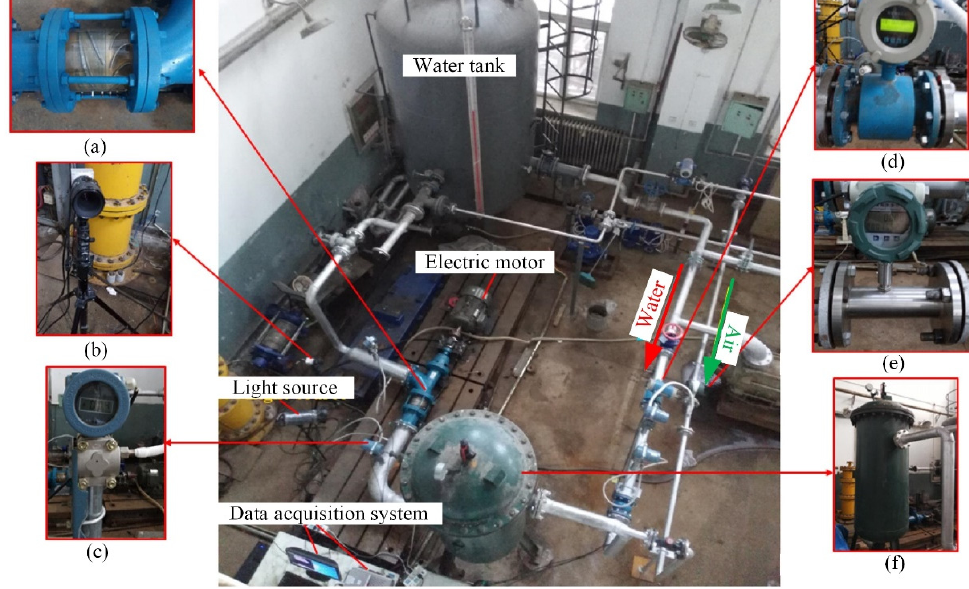
Figure 3. Test bench for the multiphase pump: ( a ) Multiphase rotodynamic pump; ( b ) High-speed camera; ( c ) Pressure transducer; ( d ) Electromagnetic flowmeter; ( e ) Turbine flowmeter; ( f ) Buffer tank.